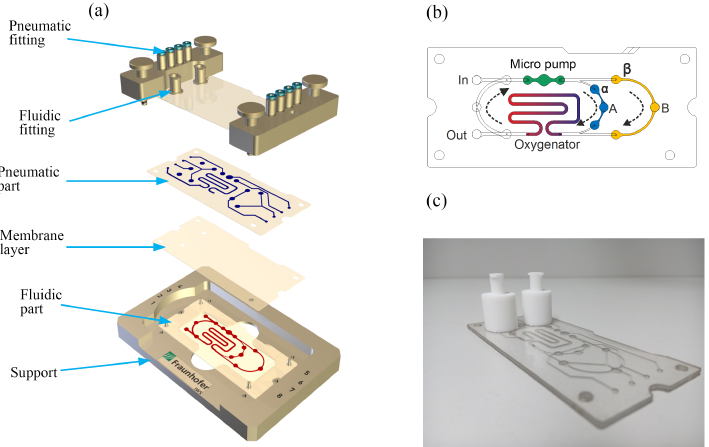
Figure 1. (a) Exploded view of the microfluidic system; (b) microfluidic layout indicating micropump, oxygenator, and measurement spots (A, B) as well as upstream and downstream valves ( α , β ); (c) picture of microfluidic system with mounted